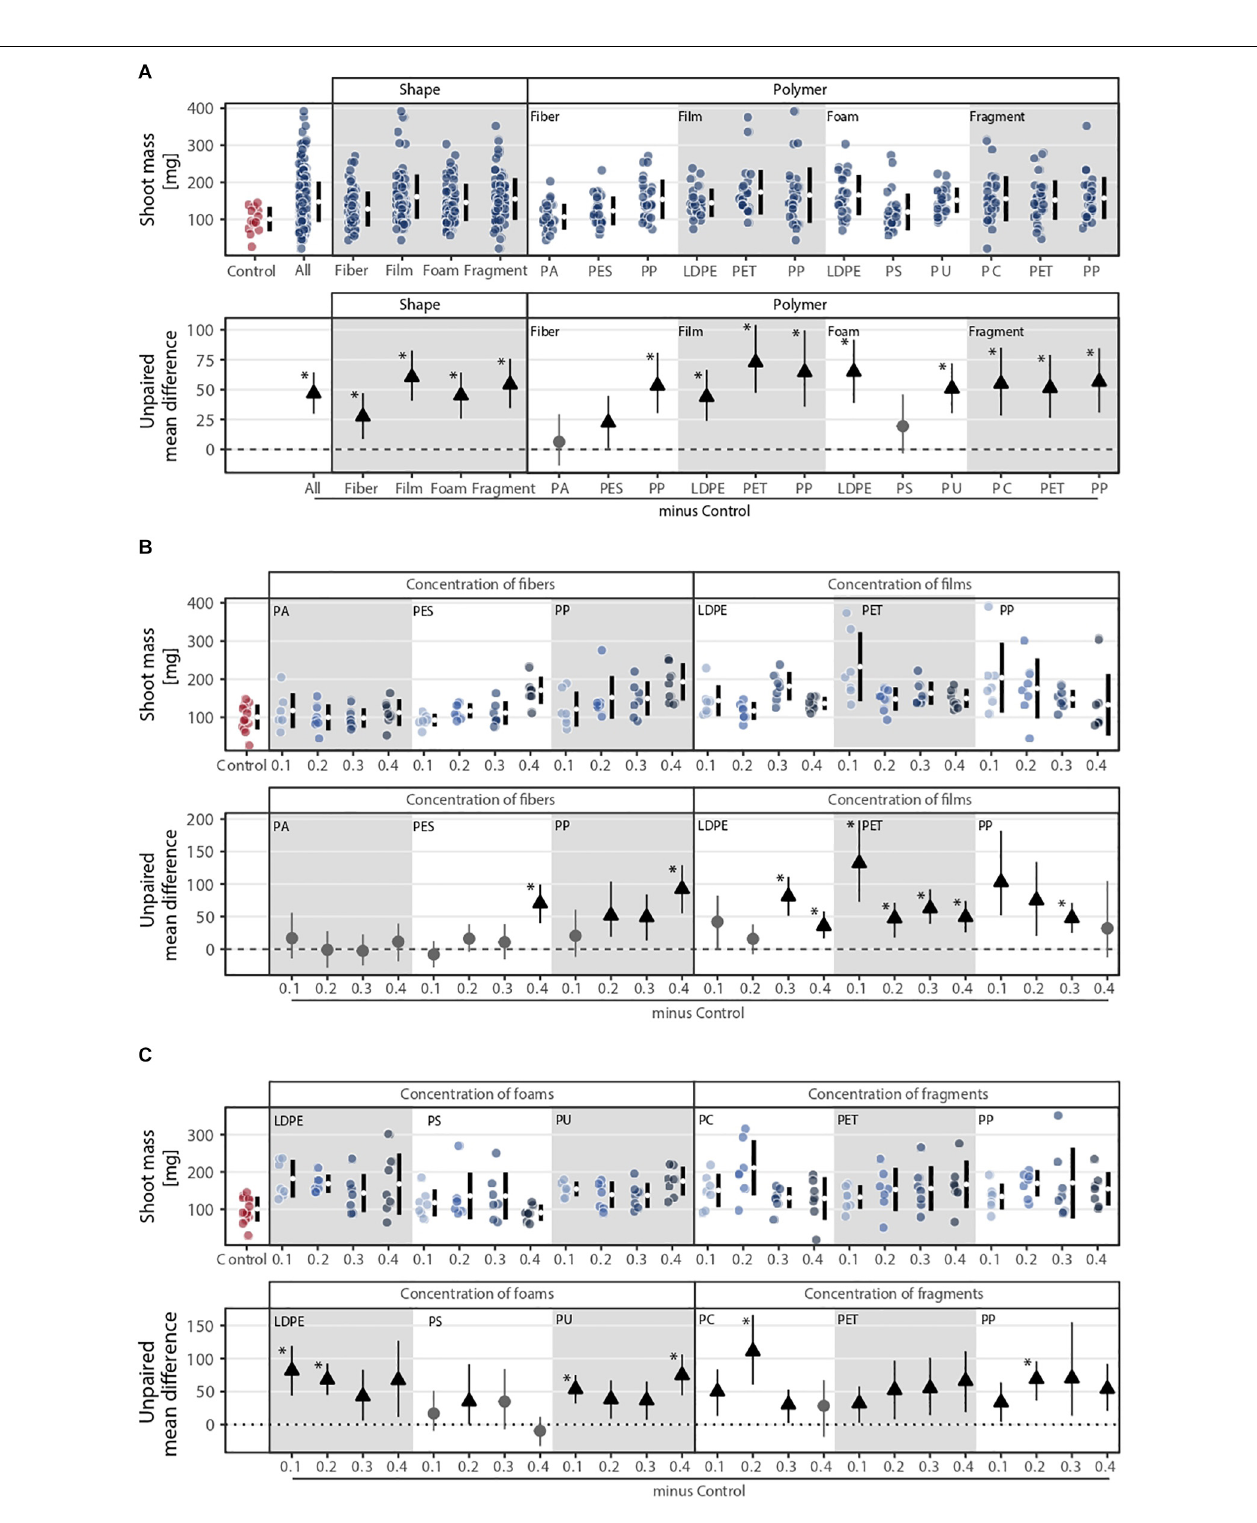
FIGURE 2 | Shoot mass response to (A) microplastic shape and polymer type at (B–C) different concentrations (0.1, 0.2, 0.3, and 0.4%). That is, (B) concentration of fibers and films and (C) concentration of foams and fragments. Effect sizes and their variance are displayed as means and 95% confidence intervals. Effects are color-coded: gray circles indicate neutral effect sizes and black arrows with an arrow head pointing upward indicate positive effects; no negative effects were detected. Horizontal dotted line indicates the mean difference value between each microplastic and the control. Polymers: PA (polyamide), PES (polyester), PP (polypropylene), LDPE (low density polyethylene), PET (polyethylene terephthalate), PS (polystyrene), PU (polyurethane), and PC (polycarbonate). Significance was established at 0.05 ( Supplementary Tables S1–S3 ); n = 7 for microplastics, n = 14 for control samples.